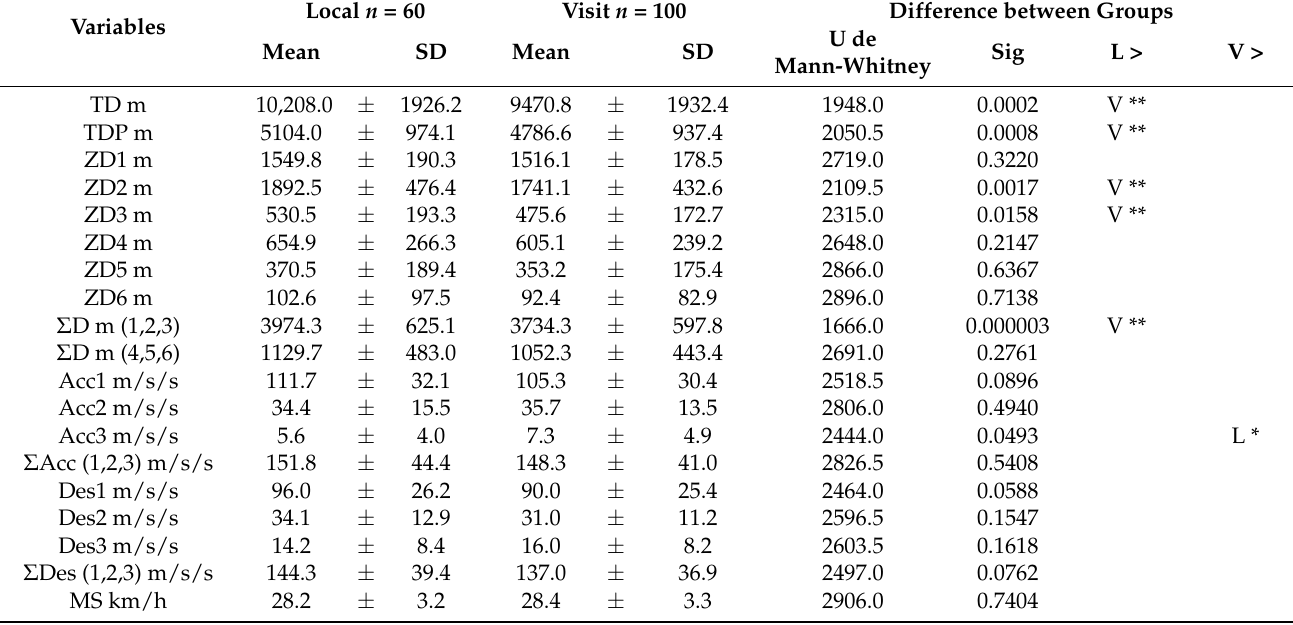
Table 6. Distances covered across each speed threshold when the teams competed home or away (Data reported as mean ±